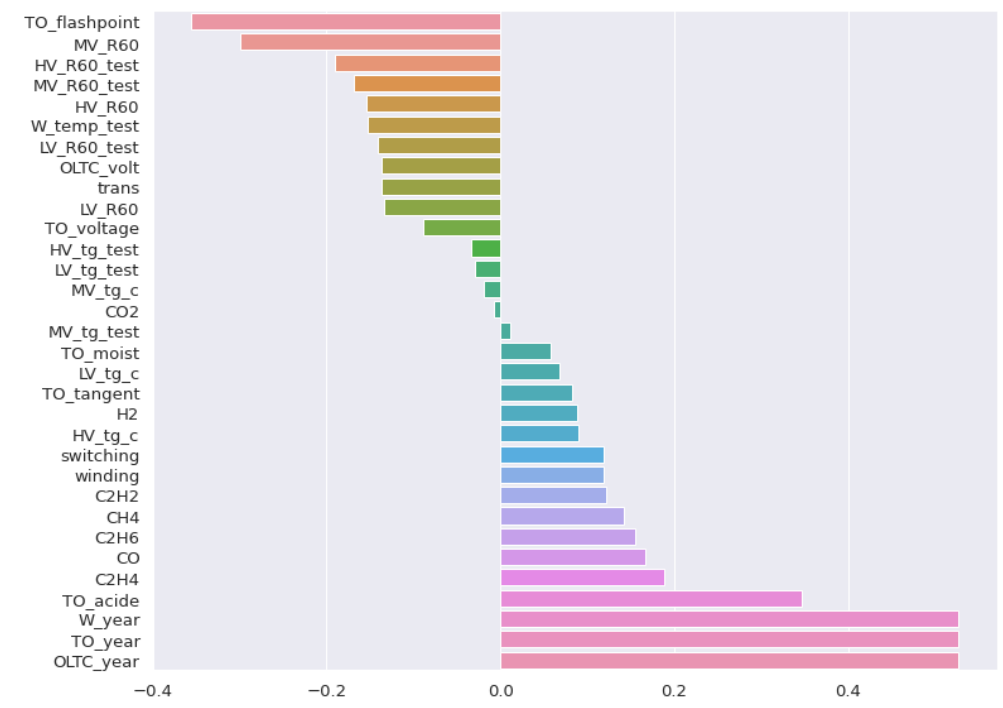
Figure 8. Fragment of Spearman cross-correlation matrix for the features.